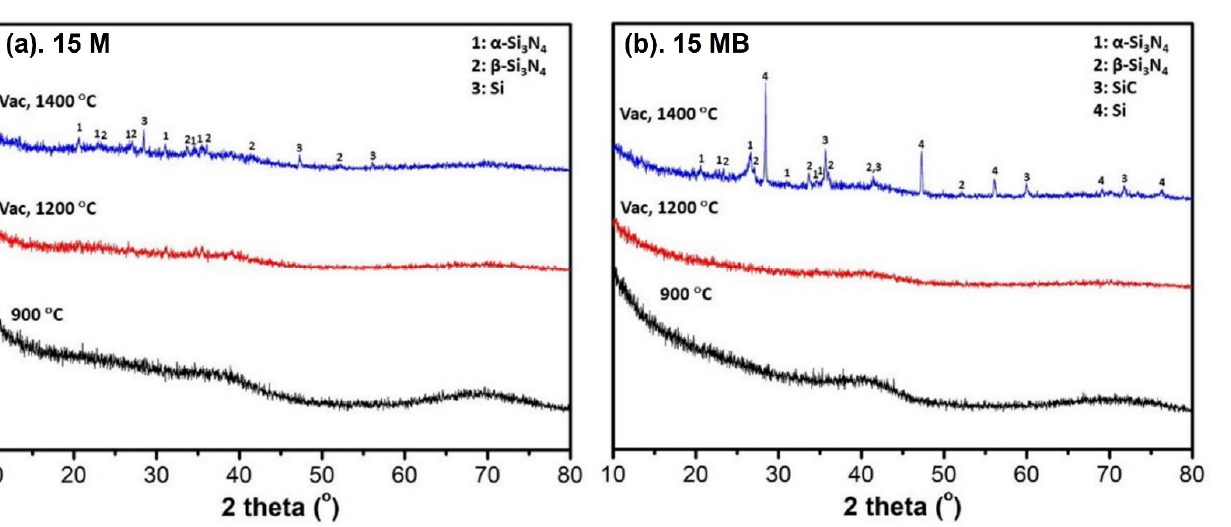
Figure 15. XRD spectra of vacuum-treated products of the two kinds of precursors at different tem- peratures ( a ) 15 M and ( b ) 15